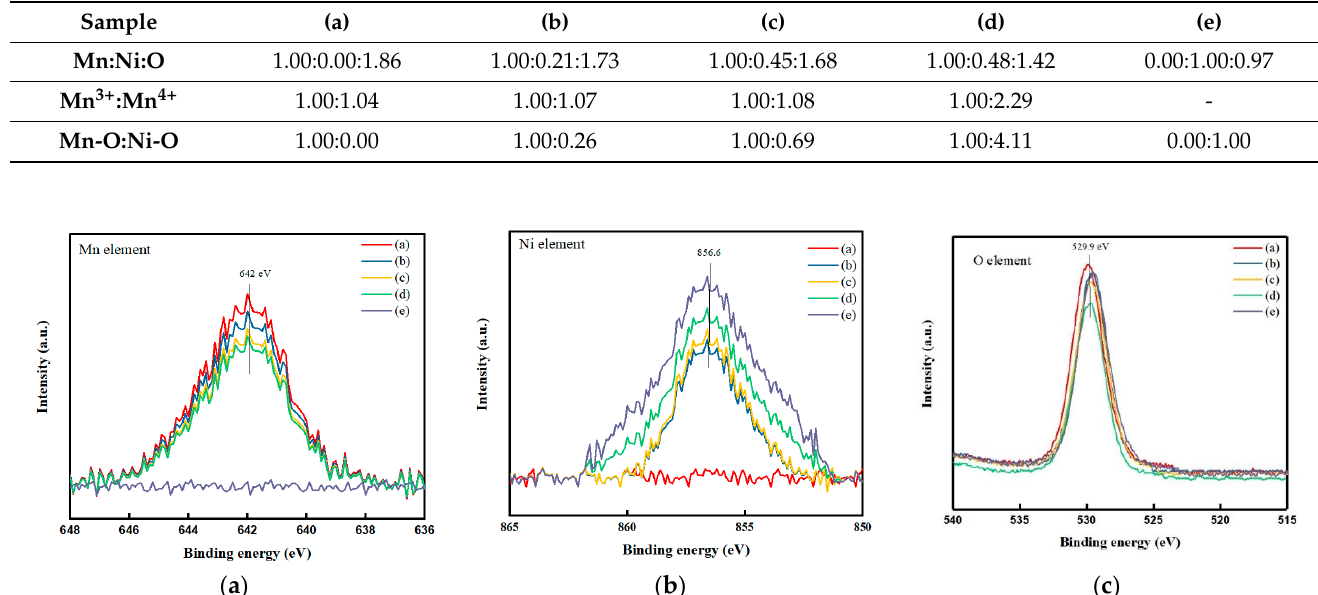
Figure 4. XPS fitting curves for ( a ) Mn element, ( b ) Ni element, and ( c ) O